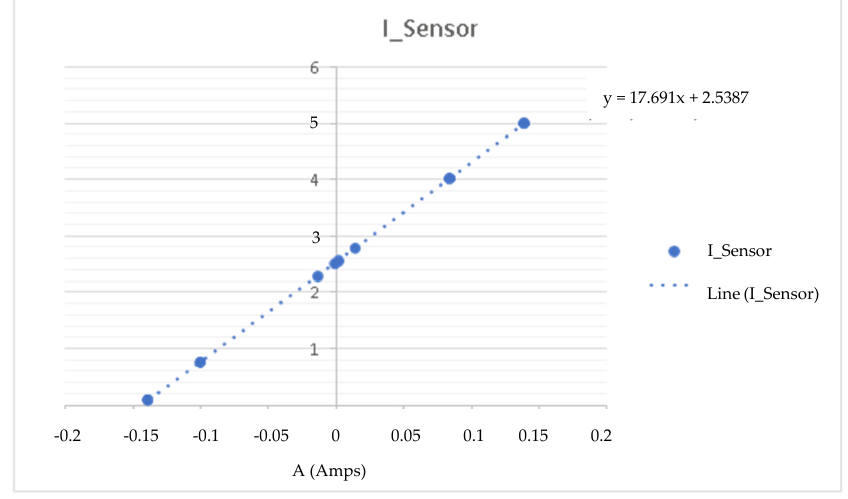
Figure 6. Intensity at the sensor.